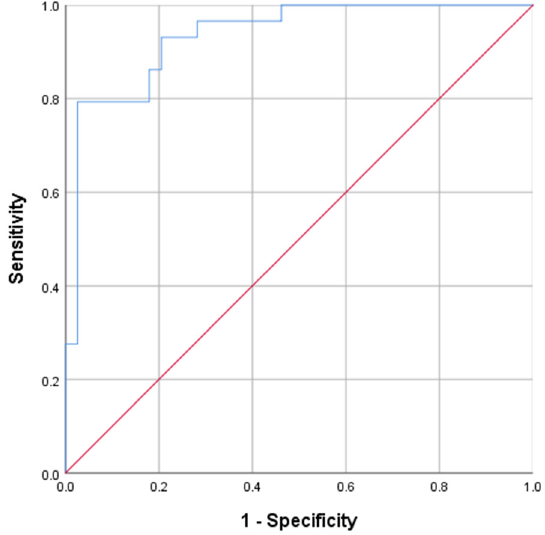
Figure 3. Receiver-operating-characteristic (ROC) curve of morning serum cortisol collected 24 h after TSS for prognosis of CD remission one year after TSS. The optimal threshold of 24 h MseC for predicting CD remission was ≤ 388 nmol/L; the sensitivity and specificity of the method were 97.4% and 79.3%, respectively ( p < 0.001, AUC = 0.935, 95% CI = 87.7–99.2%).